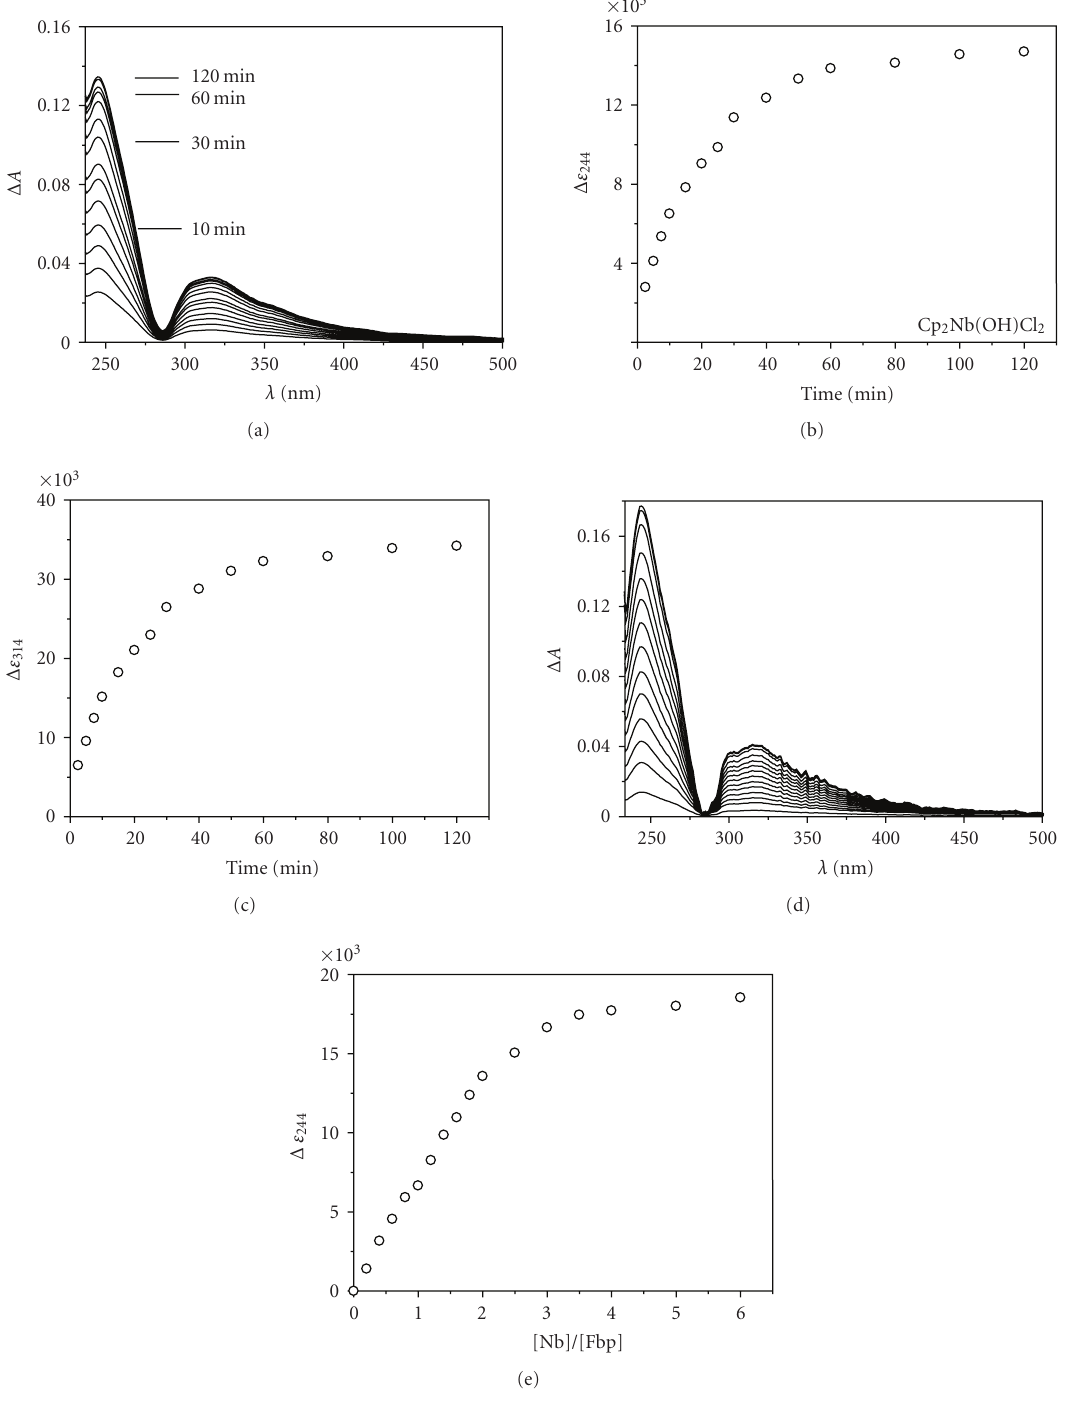
Figure 3: (a) Di ff erence UV/Vis spectra recorded at various times during the reaction of apoFbp (9.8 μ M) with 2.0mol equivalents of [Cp 2 Nb(OH)Cl 2 ] in 10mM Hepes bu ff er, 5mM phosphate, pH 7.4 (b) Time course for reactions of apo-Fbp (ca. 9.8 μ M) with 2 mol equivalents of [Cp 2 Nb(OH)Cl 2 ] in 10mM Hepes bu ff er, 5mM phosphate, pH 7.4, 310K, as a plot of molar absorptivity versus time of reaction. (c) Time course for reactions of apo-Fbp (ca. 9.8 μ M) with 2mol equivalents of [Cp 2 Nb(OH)Cl 2 ] in the 10mM Hepes bu ff er, 5mM phosphate, pH 7.4 at 310K as a plot of molar absorptivity versus time of reaction. (d) Di ff erence UV/Vis spectra for the titration of apoFbp (9.8 μ M) with [Cp 2 Nb(OH)Cl 2 ] in 10 mM Hepes bu ff er, 5mM phosphate, pH 7.4, 310 K (2h equilibration). Molar ratios of Nb- complexes: apo-Fbp from bottom to top: are 0–2.0 in 0.2mol equivalent steps, then 2.5, 3.0, 3.5, 4.0. (e) Titration curve for the reaction in (D), Δ ε is the absorbance at 244 nm divided by the Fbp